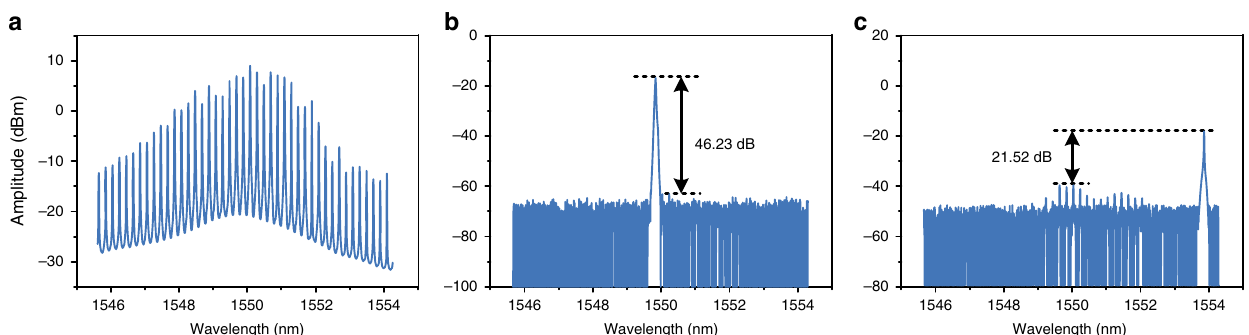
Fig. 3 The optical spectra of the OFC and the selected comb line. a The generated 43-tone OFC signal measured in a span of more than 8 nm. b The comb line in the middle of the OFC selected by OBPF2 which has an SMSR of 46.23 dB. c The comb line with an SMSR of 21.52 dB in the marginal area of the OFC selected by